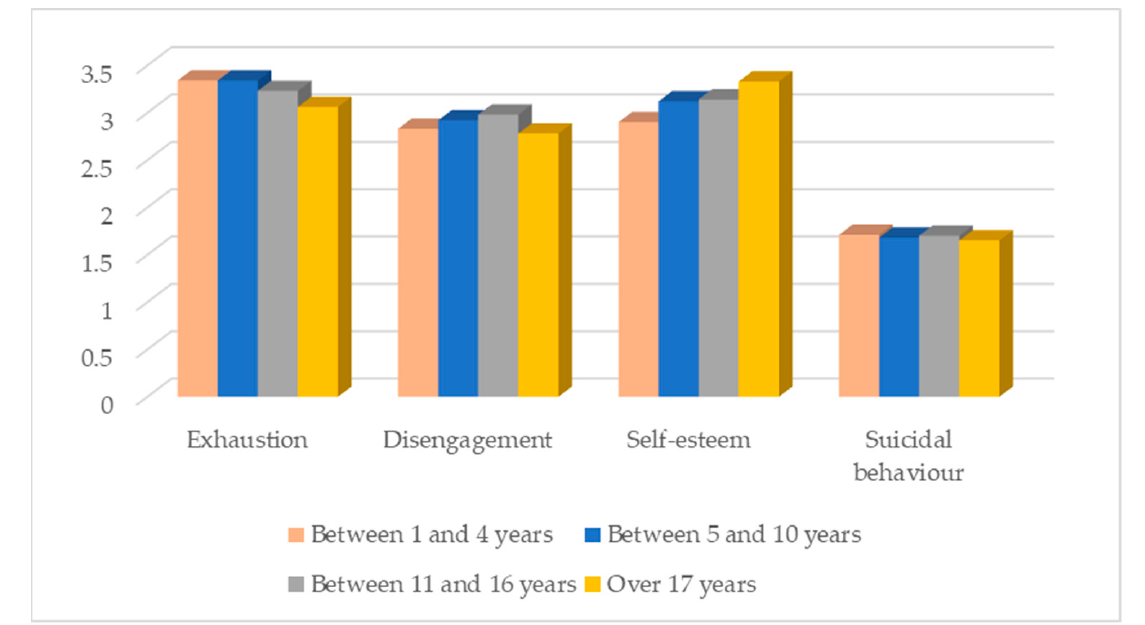
Figure 4. Distribution of the variables under study according to seniority in the job .